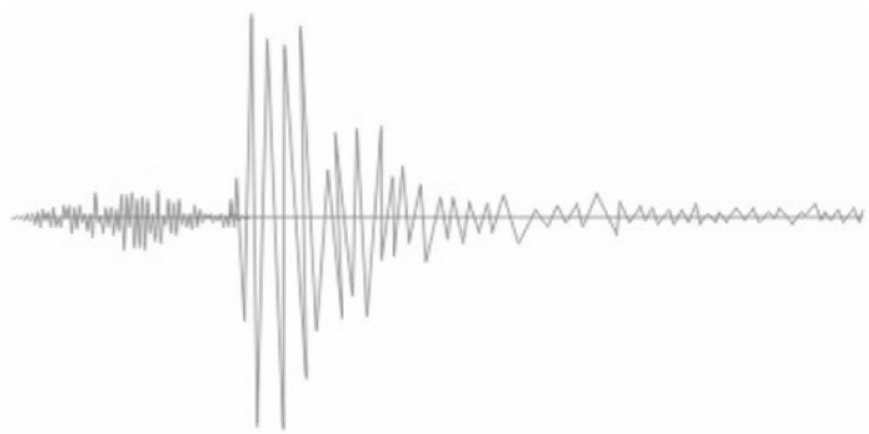
Figure 3. Typical AE signal: we can identify a very rapid rising edge followed by an exponentially decreasing trend also due to the response of the transducer, and by stationary or almost stationary signals, without